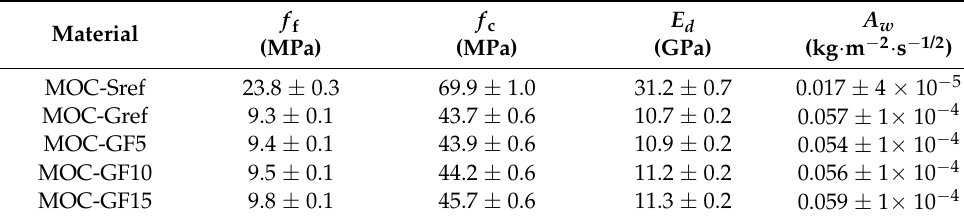
Table 6. Spread diameter and basic macrostructural parameters of developed composites.